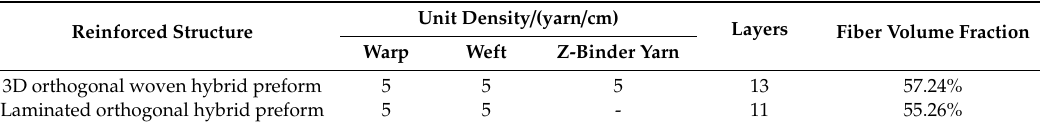
Figure 1. Schematic diagrams of ( a ) the 3D orthogonal woven hybrid preform (1#), ( b ) the laminated orthogonal hybrid preform (2#), and ( c ) the laminated orthogonal hybrid preform (3#). Table 1. Performed parameters of the 3D orthogonal woven hybrid preform and the laminated orthogonal hybrid preform.